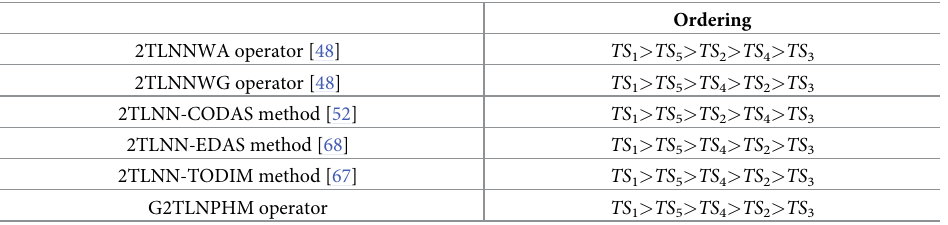
Table 6. Ordering of the different